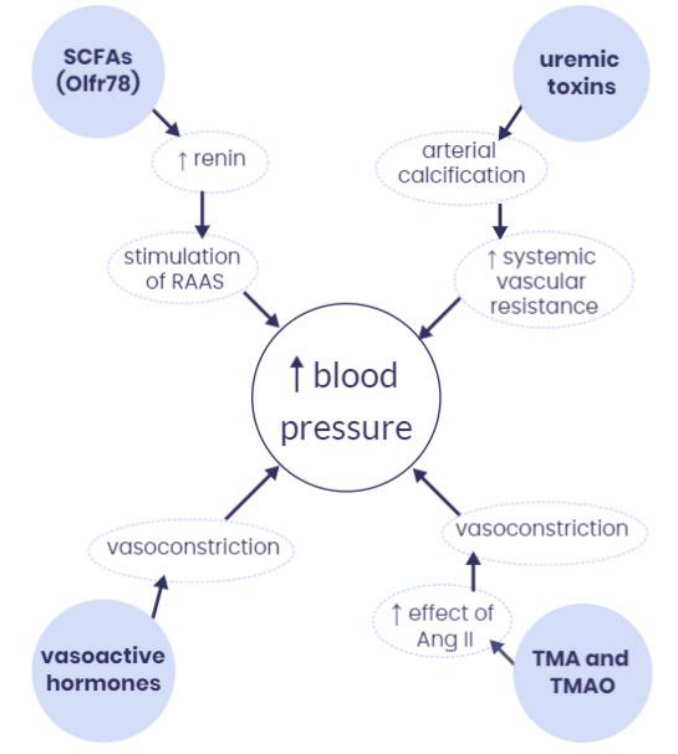
Figure 2. The most important microbiota-derived metabolites and their interactions with blood pressure. SCFAs — short-chain fatty acids; RAAS — renin-angiotensin-aldosterone system; Ang II — angiotensin II; TMA — trimethylamine; TMAO — trimethylamine N-oxide, Olfr78 — olfactory receptor 78, ↑ — increase.